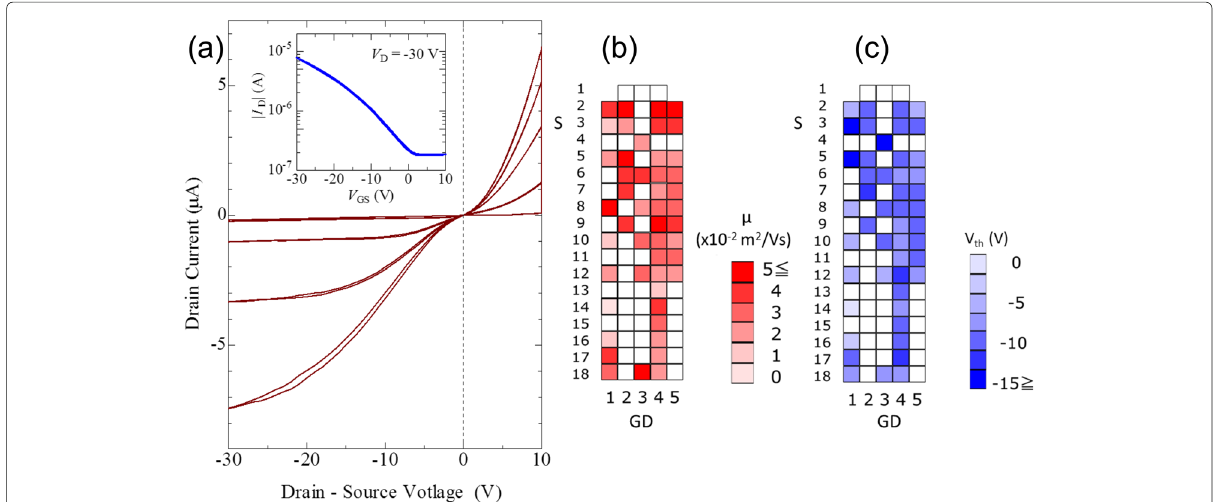
Fig. 4 a Typical output and transfer characteristics of fingertip-shaped OTFT array. Maps of the observed b field-effect hole mobility and c threshold voltage in the OTFT array, respectively. The colored pixels indicate working OTFTs, and the empty pixels indicate poor FET